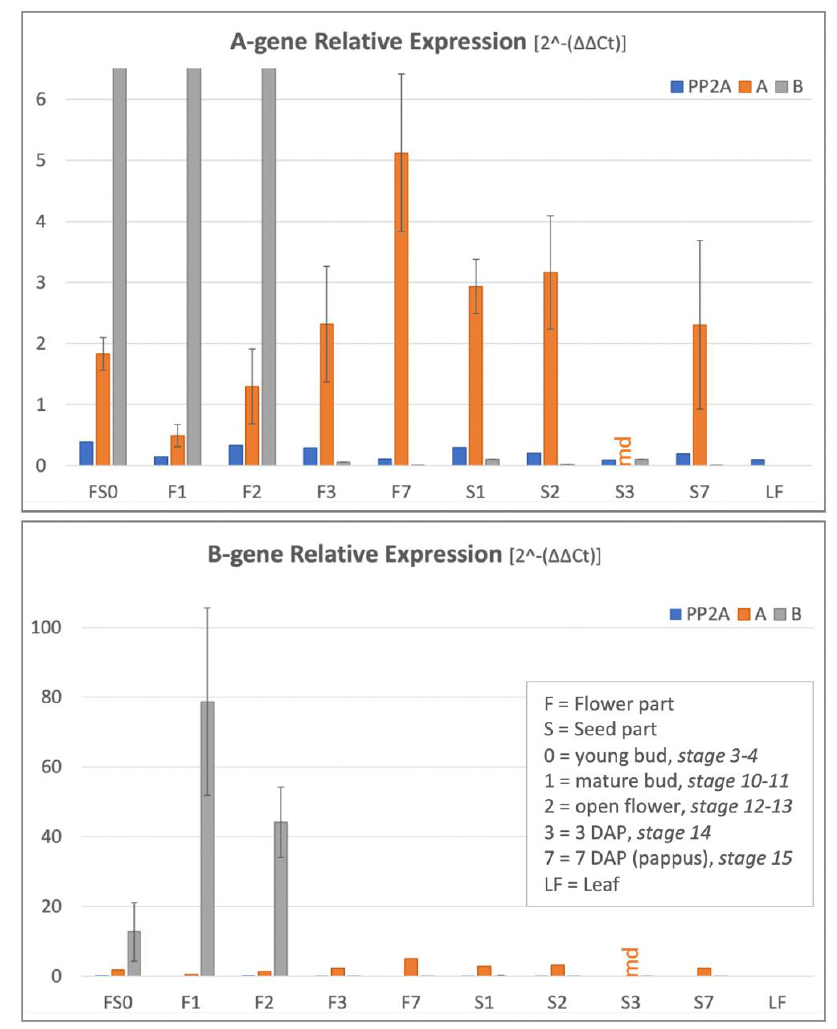
Figure 7. Relative A-gene ( Tof-APETALA 1) and B-gene ( Tof-PISTILLATA ) expression in dandelion floral tissues at different developmental stages. F = upper floral tissues (including the pappus, petals, stamen with anthers, style with stigmas, and upper half of the beak); S = lower floral tissues (including the ovaries and lower half of the beak); LF = leaf; numbers are explained in the graph and stages in Table 1; DAP = days after pollination; F7 = pappus only; md = missing data. The two graphs are the same, but differently scaled to highlight the small but relevant variation in the A-gene expression (( upper ) graph) and ~20x higher expression of the B-gene compared to the A-gene (( lower ) graph). Tof-AP 1 (orange bars) is weakly expressed in all tissues and stages analysed with a gradual increase in maturing florets (F1 to F3), being highest in the mature pappus (F7). Tof-PI (grey bars) is highly expressed in the floral tissues that contain petals and anthers up to anthesis (F0 to F2) and absent in pappus (F7). Tof-PP 2A (blue bars) is a second reference gene, showing the same pattern as Tof- UBC 9. These results verify the ABC-model of floral development, supporting the homology of the pappus with the sepals.